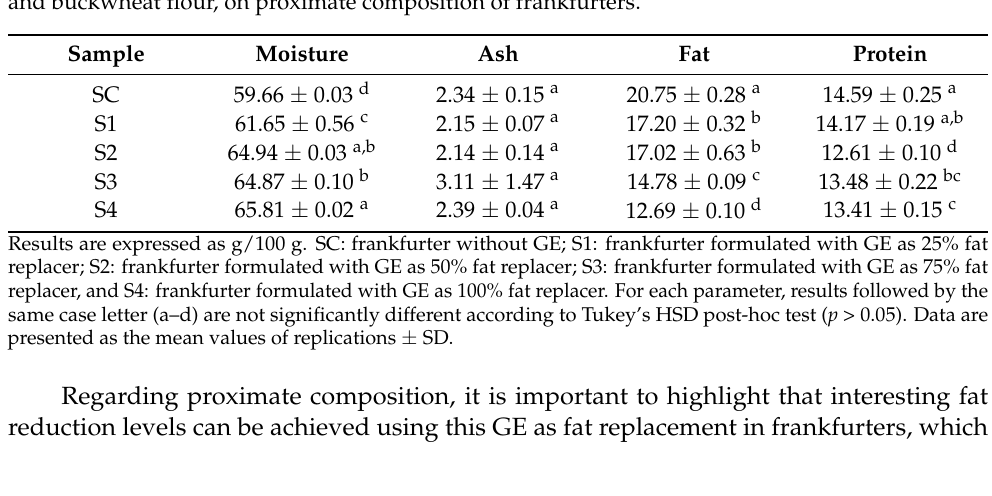
Table 1. Effect of partial and total replacement of pork back fat by the gelled emulsion from hemp oil and buckwheat flour, on proximate composition of